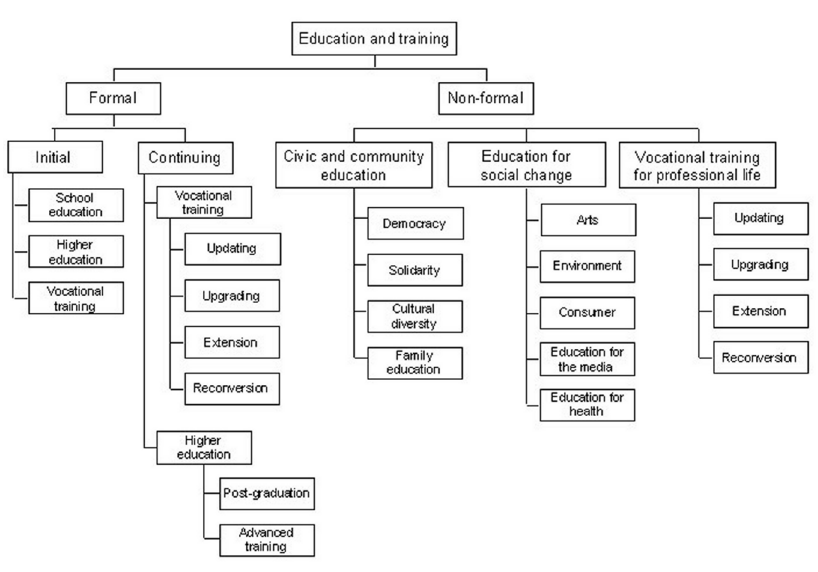
Figure 1: Different types of education and training situations and connections between various